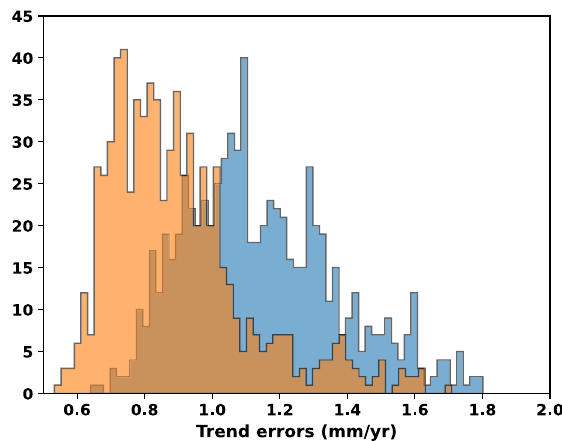
Fig. 9 Distribution of coastal (blue bars) and offshore (orange bars) trend errors (in mm/yr). The histograms show that the coastal trend errors are slightly higher, on average, than offshore trend errors.